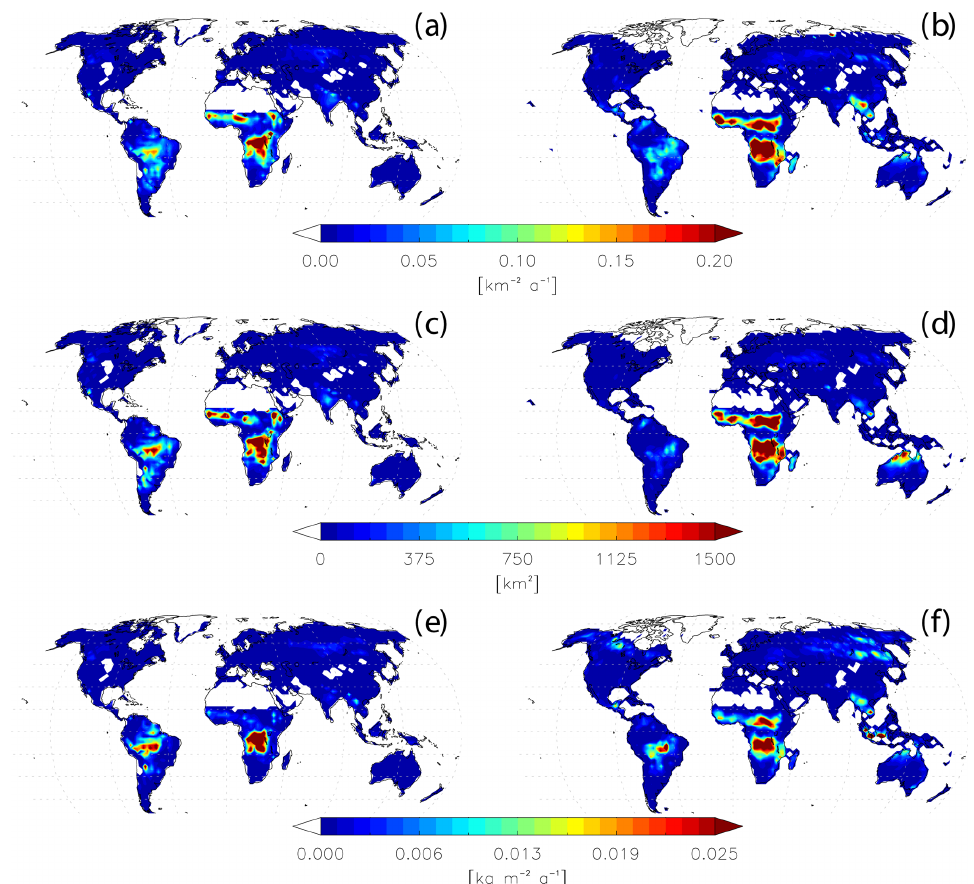
Figure 8. Annual mean model (a, c, e) and satellite-based (b, d, f) active fires (a, b) , burned area (c, d) , and CO emissions (e, f) . Modeled annual mean is based on an ensemble of 10 simulations. Satellite-detected active fires are based on MODIS Aqua retrievals of 2003–2016, burned area is based on GFED4s inventory of 2003–2016, and CO emissions are based on climatological GFED4s emissions of